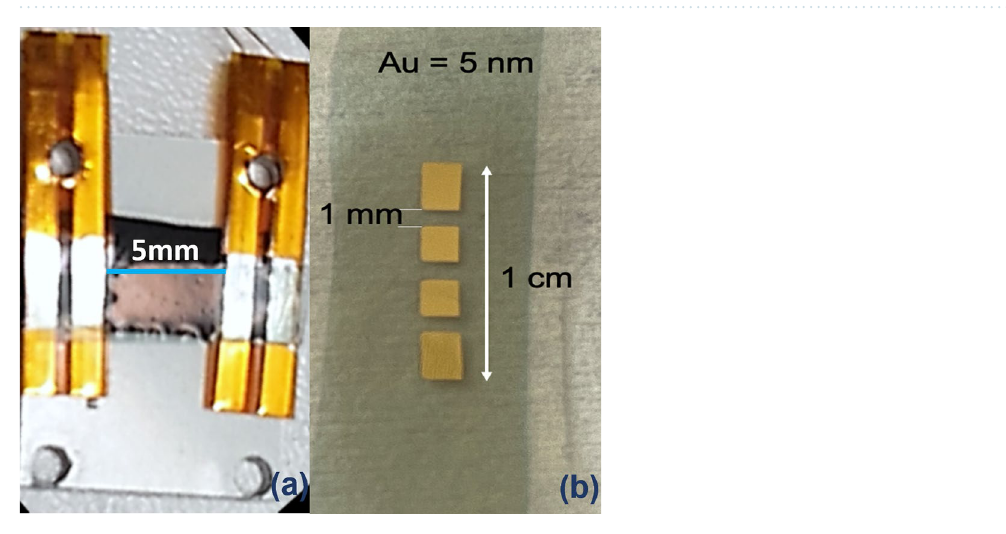
Figure 10. Electrical contacts configuration. ( a ) Photograph of the sample holder used for measurements realized with mechanically pressed contact pads. ( b ) Photograph of a typical investigated sample with inline Au pads deposited onto the surface for the electrical